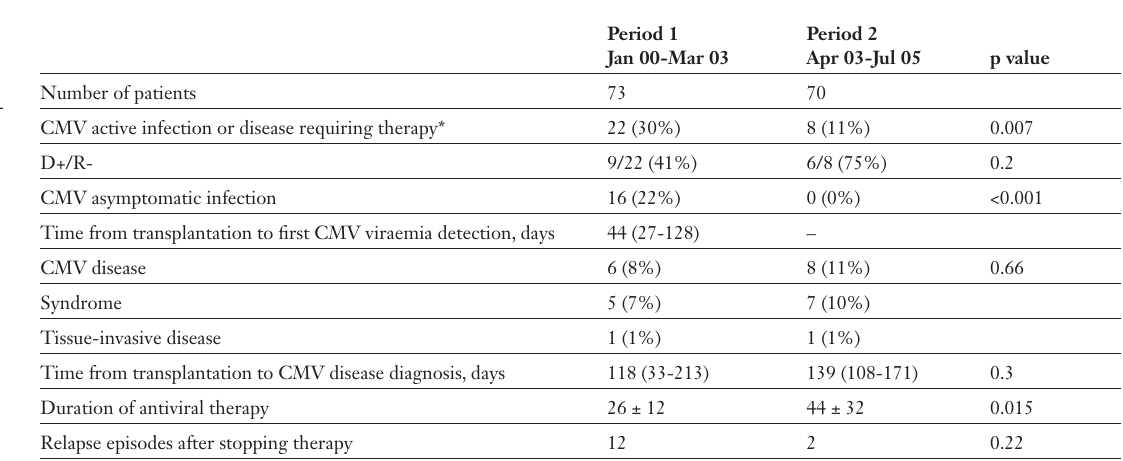
Incidence of CMV in- fection at 12 months after organ transplan-